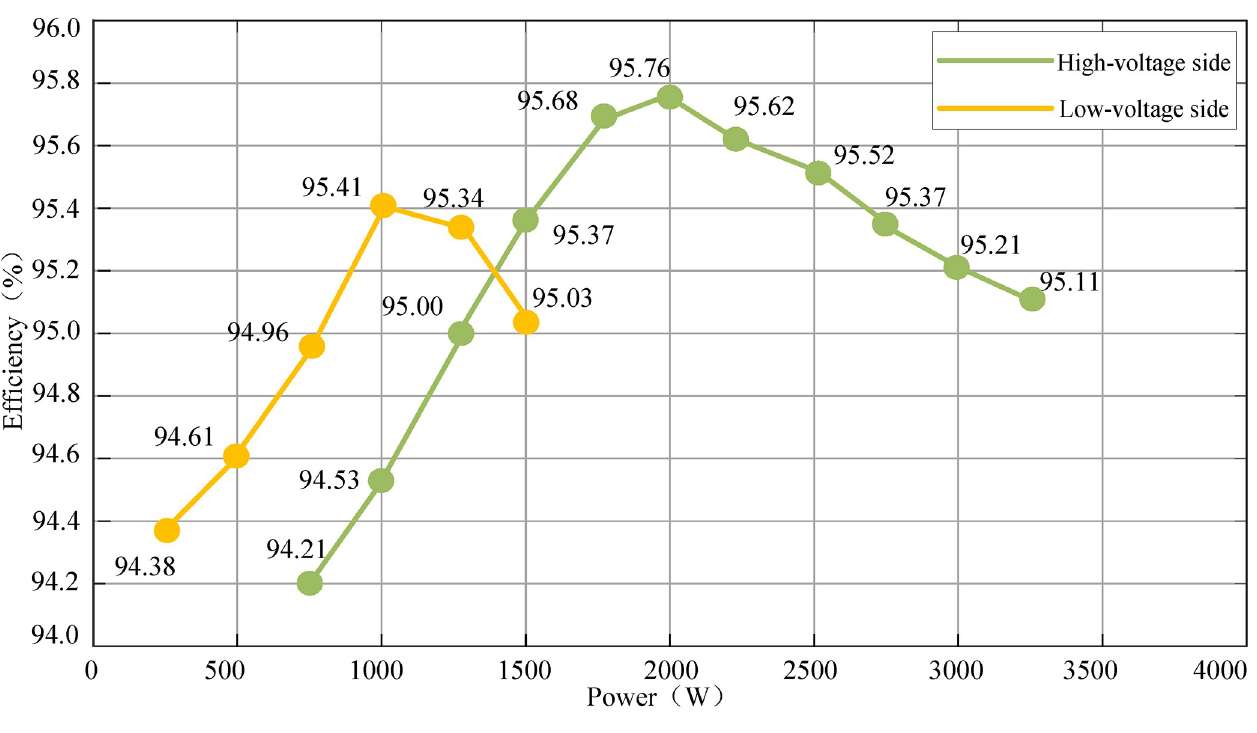
Fig 32. The diagram of charge operation